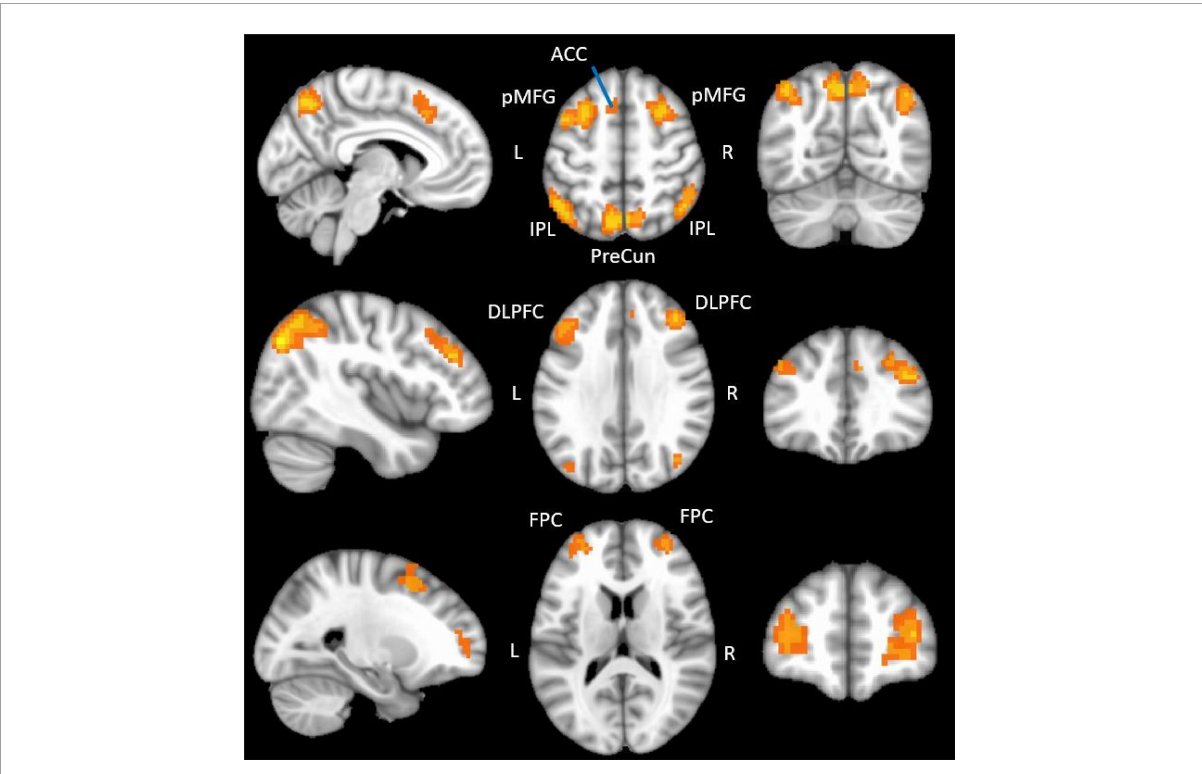
FIGURE1 fMRI regions showing functional activation during the N-back tasks. The figure displays the positive functional activation using a group level functional contrast [(2-back/2 + 1-back/2) > Compare] overlaid onto a 1 mm MNI ICBM152 template (MNI ICBM152 1 mm 6th generation atlas; Grabner et al., 2006). fMRI data were thresholded (q = 1 × 10 - 10 ) and clusterized (minimum cluster size = 20) in this figure to optimize display. ACC, anterior cingulate; pMFG, posterior middle frontal gyrus; IPL, inferior parietal lobule; PreCun, precuneus; DLPFC, dorsolateral prefrontal